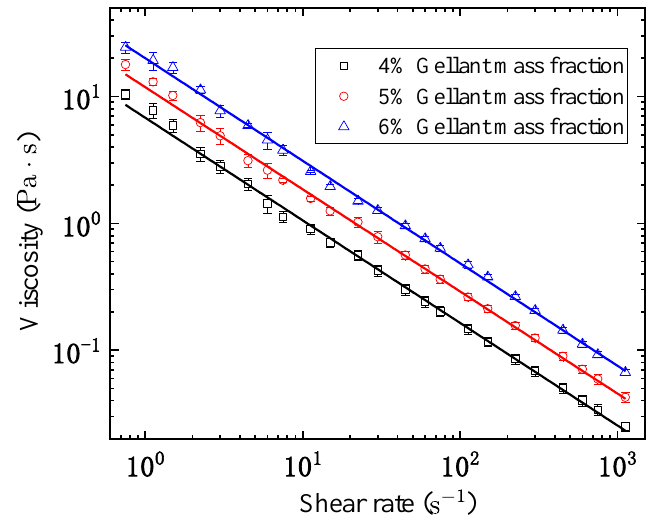
Figure 1. The relationship between 𝜂 and 𝛾̇ of organic kerosene gel with different gellant contents after intense shear. Table 1. Parameters in the power law model for organic kerosene gel after intense shear. Gellant Mass